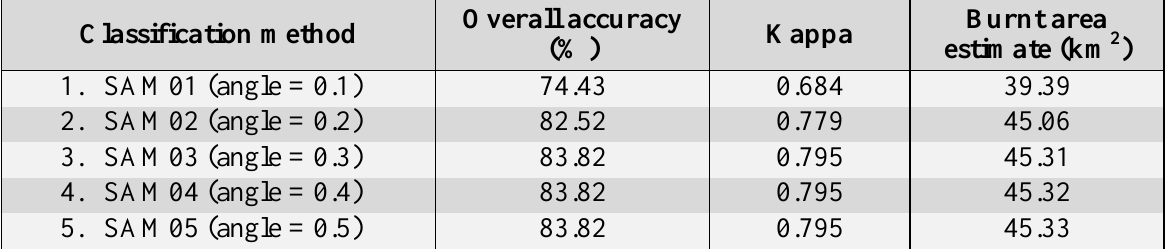
Table 1. Results obtained during experimentation of different spectral angle maximum threshold values for SAM classifier